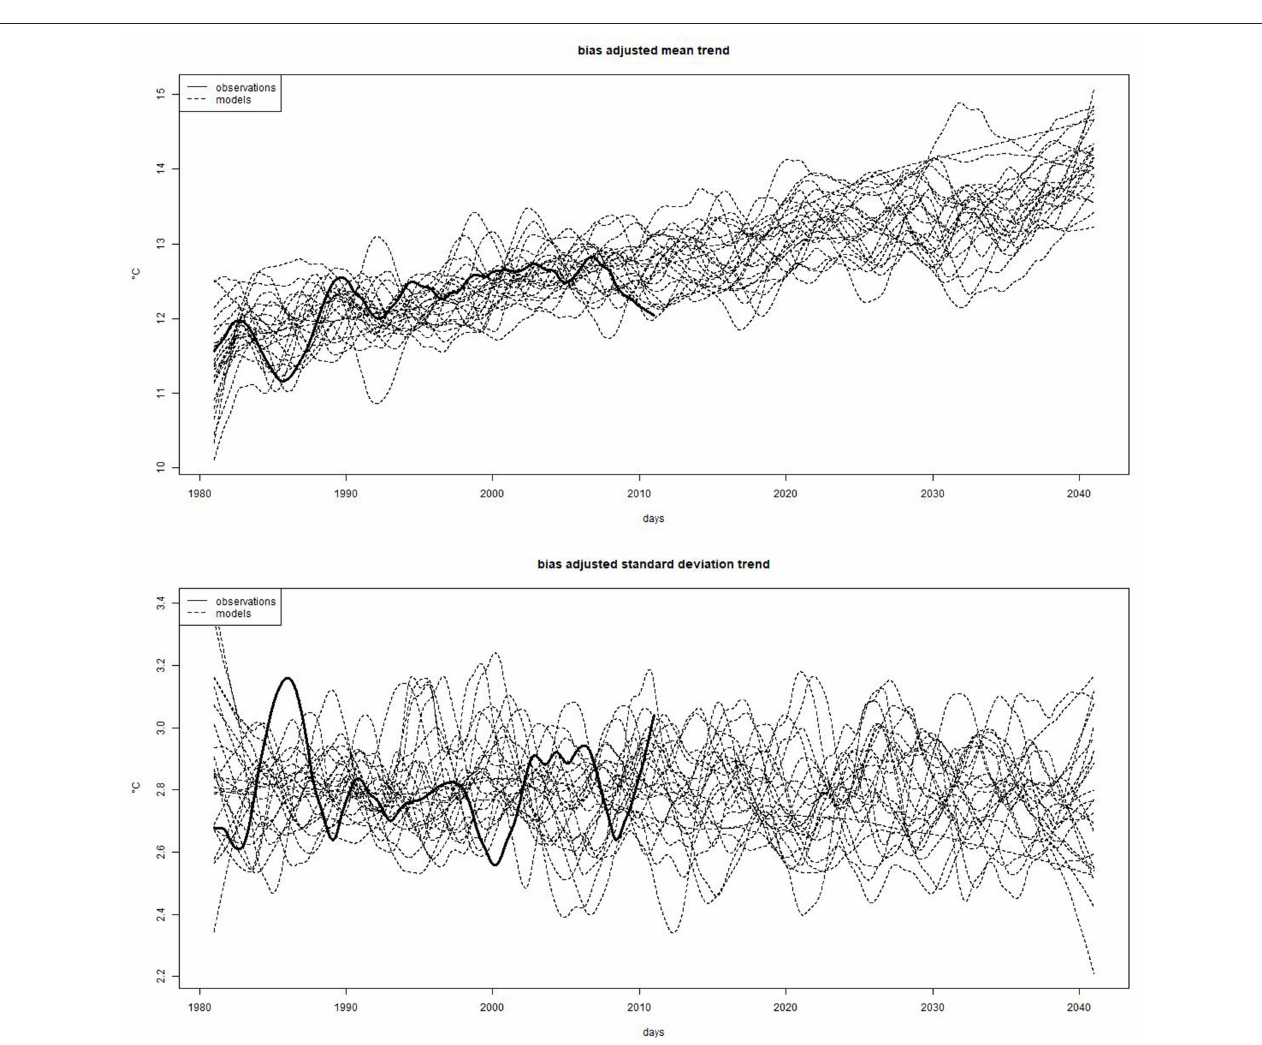
FIGURE 8 | Bias-adjusted trends in mean (top panel) and standard deviation (bottom panel) obtained from the 23 climate model simulations for the period 1981–2040 (dotted lines) with the observed trends in period 1981–2010 superimposed (black line).